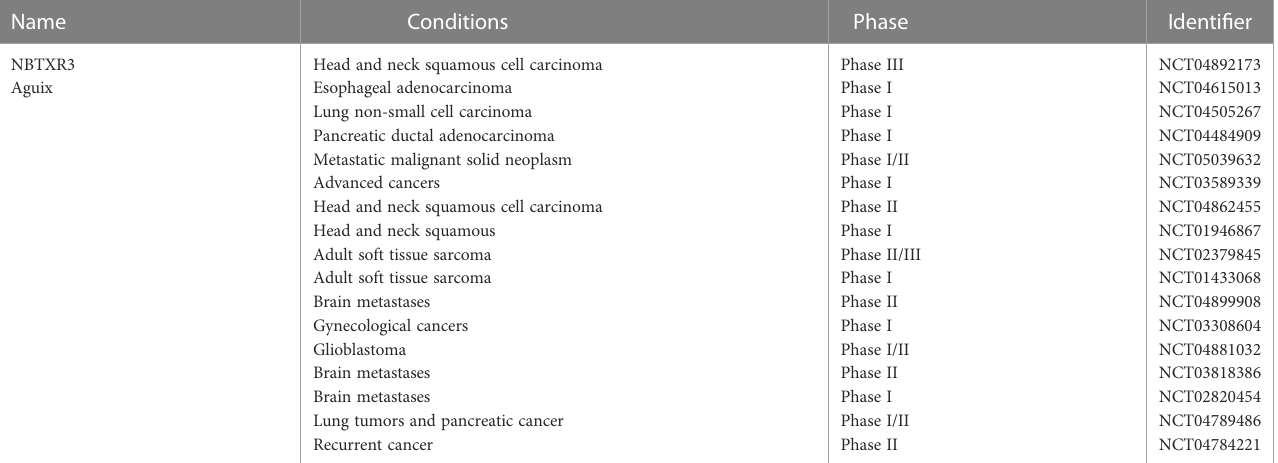
TABLE 1 Clinical translation of some